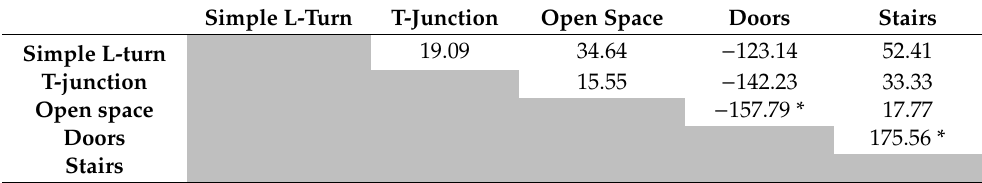
Table 6. Test statistics Z of post hoc Dunn test for confusion ratings on the videos grouped per type. Simple L-Turn T-Junction Open Space Doors Stairs Simple L-turn